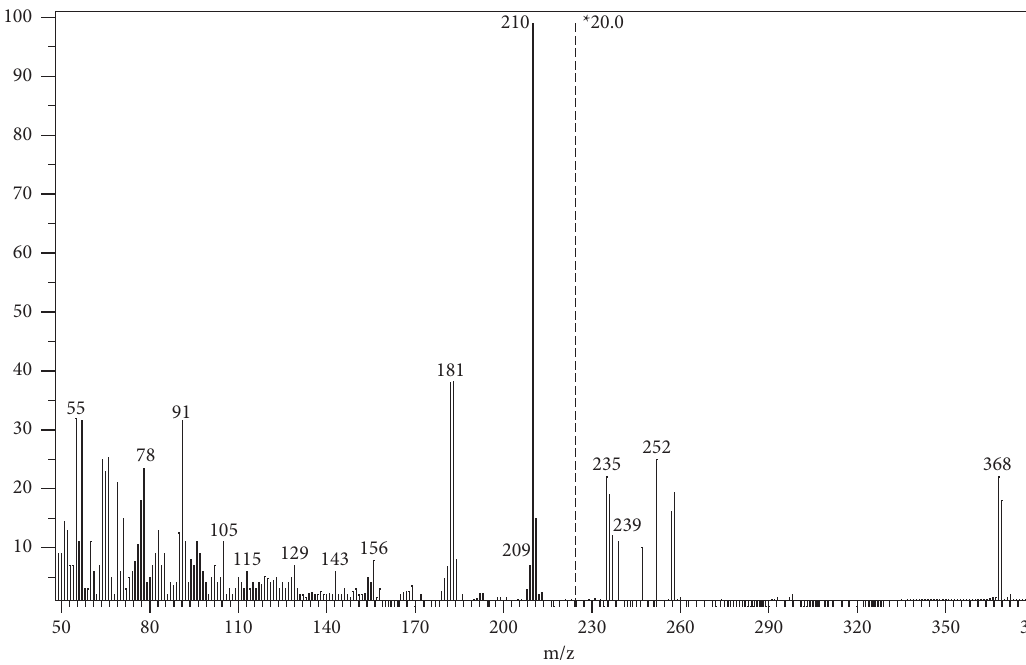
Figure 3: EI-Mass spectrum of the synthesized Al +3